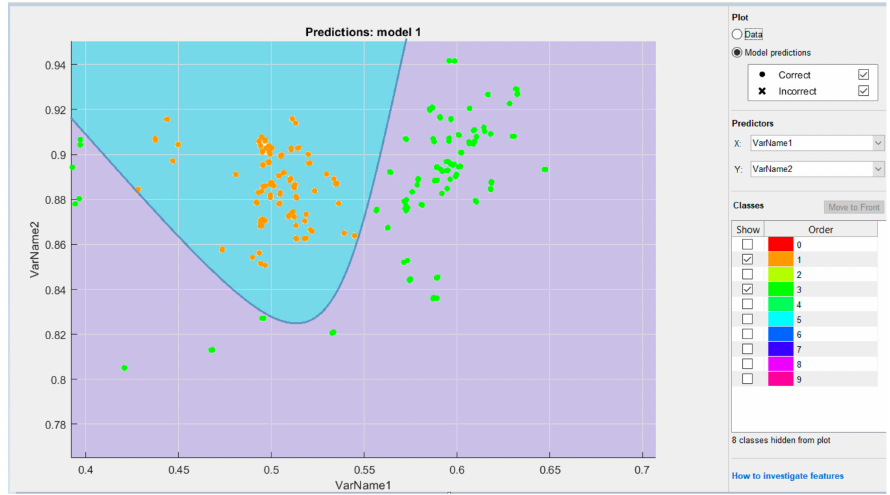
Figure 13. One-dimensional dataset with a